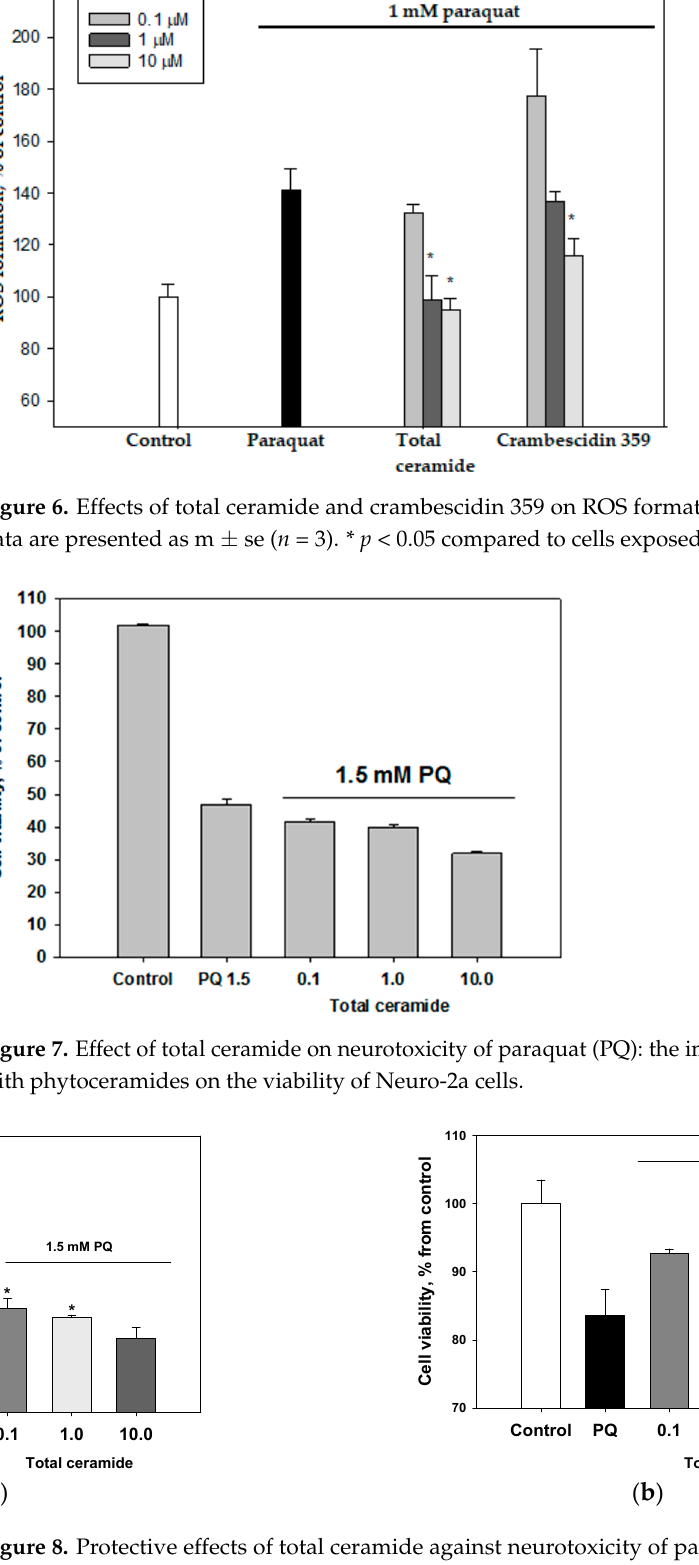
( d ) Figure 5. Cytotoxic e ff ects of cisplatin (IC 50 concentration) in combination with total ceramide (var- ious concentrations) on ( a ) MDA-MB-231 cells, ( b ) HL-60 cells, ( c ) MDA-MB-231 cells after their 24 h pre-incubation with total ceramide, and ( d ) HL-60 cells after their 24 h pre-incubation with total ceramide. Total ceramide at the concentrations of 1 and 10 µM signi fi cantly reduced ROS for- mation (by 29.8 ± 6.7% and 32.5 ± 3.2%, respectively) in neuroblastoma cells exposed to paraquat (Figure 6). In this experiment, phytoceramides in non-cytotoxic concentrations were incubated with the cells for 1 h before paraquat was introduced into the culture. After analogous short-time pre-treatment (1 h) of the neuroblastoma cells with total